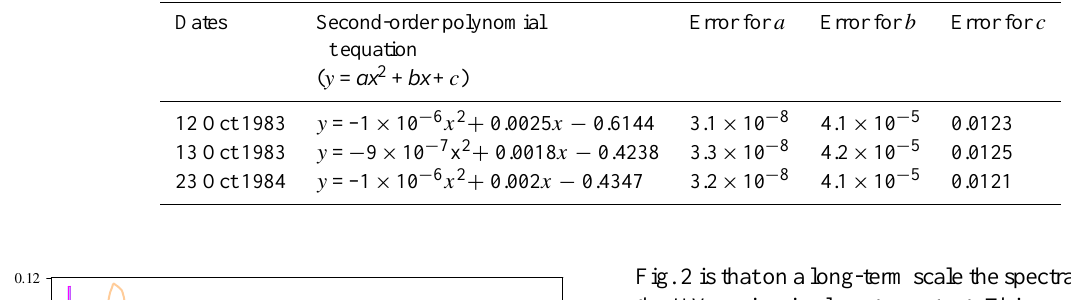
Table 5. Fit equations along with the errors of the coefficients for sand albedo and for the three dates shown in Fig. 4. All given a , b , and c values are statistically significant at the 95% confidence interval. Dates Second-order polynomial